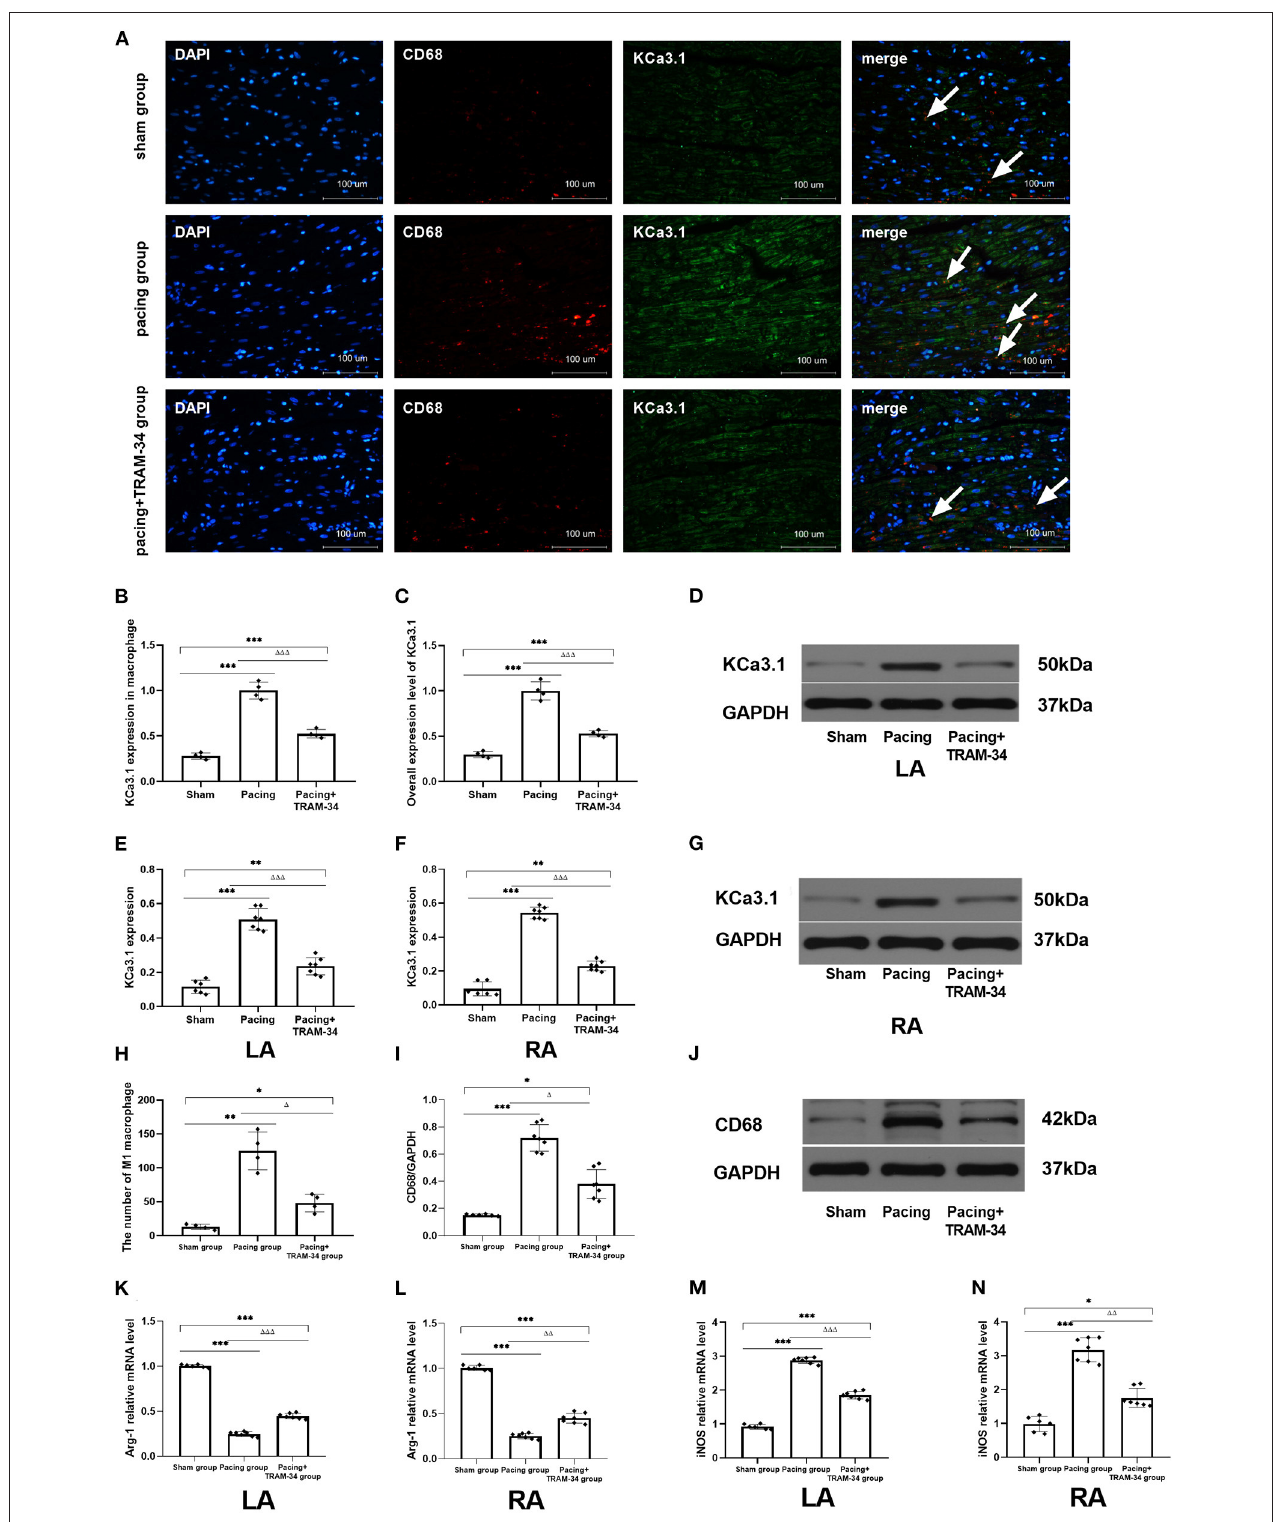
FIGURE 2 | (A) Representative atrial sections double labeled immunofluorescence for KCa3.1 and CD68-marked macrophage (while arrow). (B) Immunofluorescence analysis indicated that the expression of KCa3.1 in macrophage in the atrium was significantly higher in the pacing group than in the sham group and pacing + TRAM-34 group. (C) Immunofluorescence analysis indicated that the overall expression level of KCa3.1 (mainly in cardiomyocytes according to the